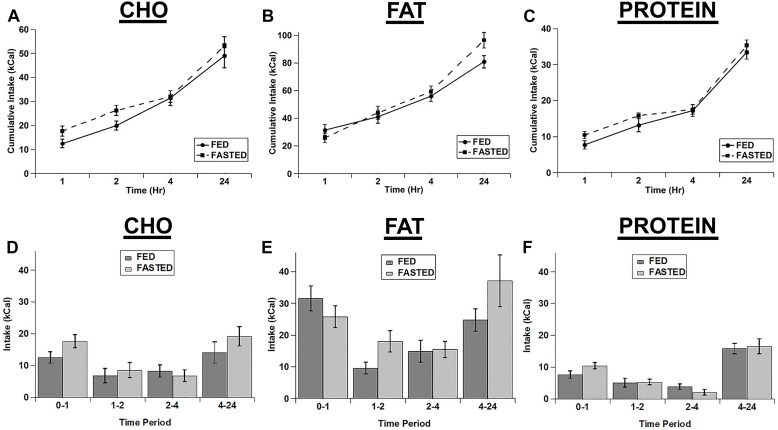
Fasting did not significantly increase the intake of any of the test diets. Cumulative intake of the carbohydrate (A), fat (B), and protein (C) diets in fasted and ad libitum fed rats. Test diet intake during each individual time period (Non-cumulative) of the carbohydrate (D), fat (E), and protein (F) diets in fasted and ad libitum fed rats. Note the differences in the scale of the Y-axis for panels A–C. n = 8–12.